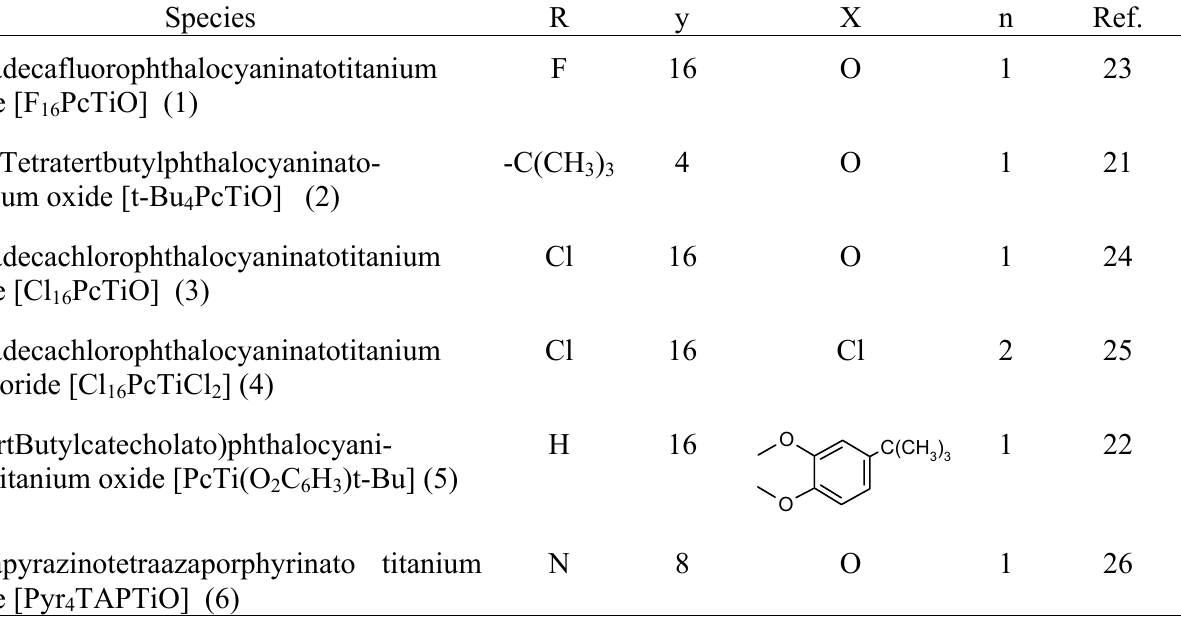
Table 1. List of phthalocyaninatotitanium(IV) oxide studied for OL generation in this work. Species R y X n